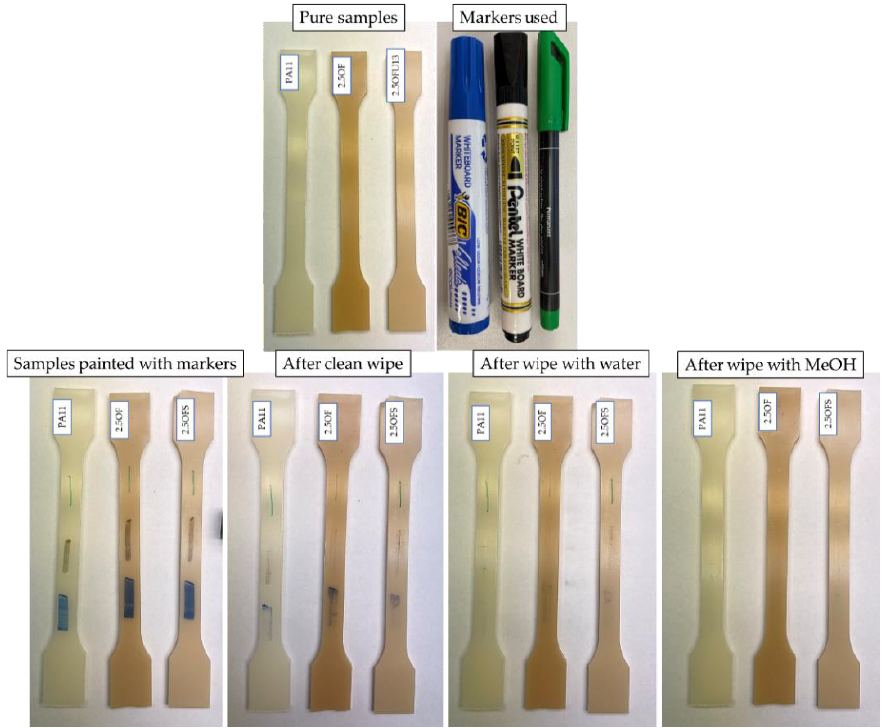
Figure 22. Washability test.